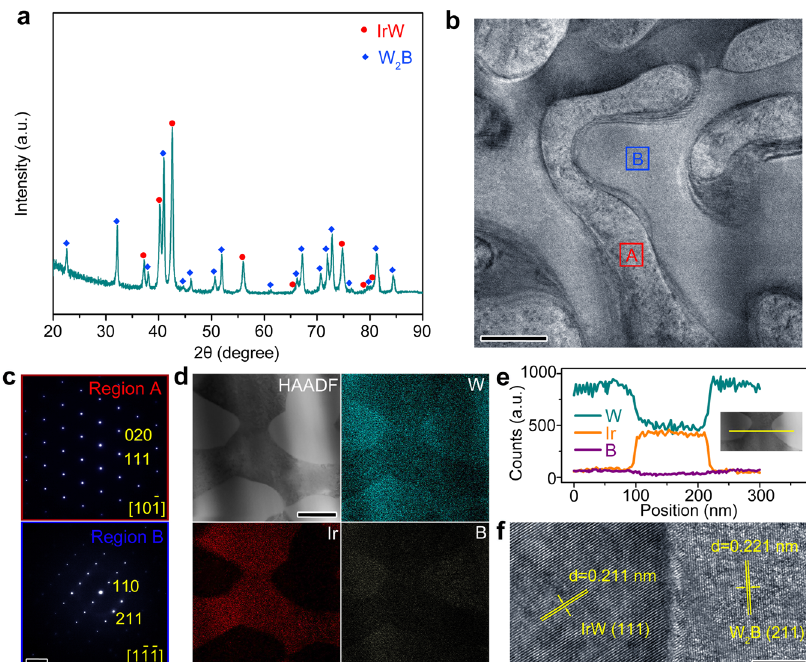
Fig. 1 Characterizations of the W-Ir-B alloy catalyst (atomic ratio, 60 : 20 : 20). a XRD patterns of the rapidly solidi fi ed alloy rod with a diameter of 1 mm. b TEM image of the W-Ir-B alloy. c SAED patterns of the different regions marked in Fig. 1b. Region A: IrW phase (red solid box); Region B: W 2 B phase (blue solid box). d HAADF-STEM image and the corresponding EDS elemental mapping of the W-Ir-B alloy catalyst. e STEM-EDS line-scanning pro fi le of the separated phases of the W-Ir-B alloy catalyst. The inset shows the selected area for EDS line-scanning analysis. f HRTEM image of the phase-separated